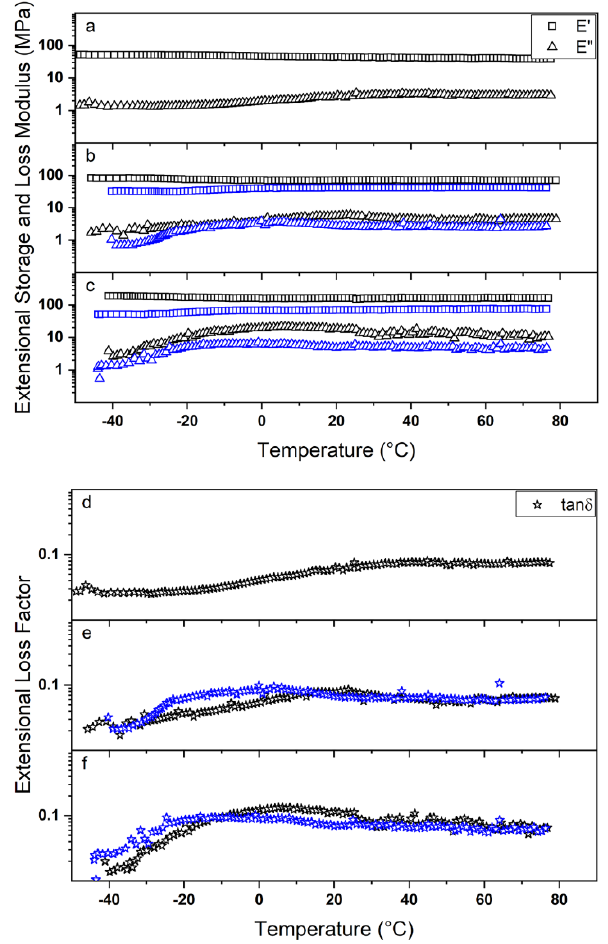
Figure 5. Dynamic-mechanical-thermal behaviour for PVP membranes obtained with collector rotation speeds of 0 rpm ( a – d ), 250 rpm ( b – e ), and 500 rpm ( c – f ). Black and blue symbols represent the properties along and perpendicularly to the fibre orientation direction, respectively. Square, triangle, and star symbols indicate the Extensional Storage Modulus, the Extensional Loss Modulus, and the Extensional Loss Factor, respectively.